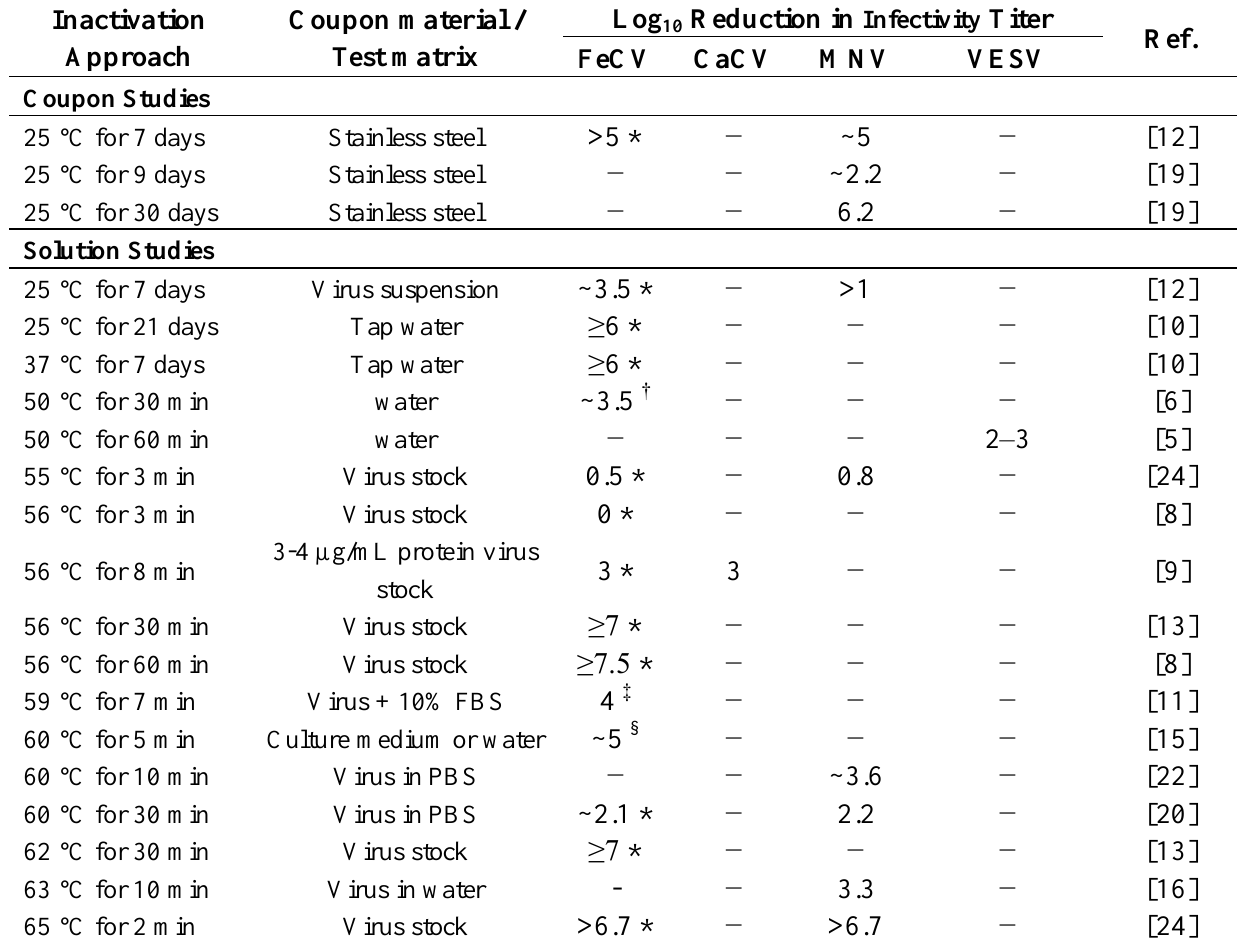
Table 1. Inactivation of caliciviruses at various